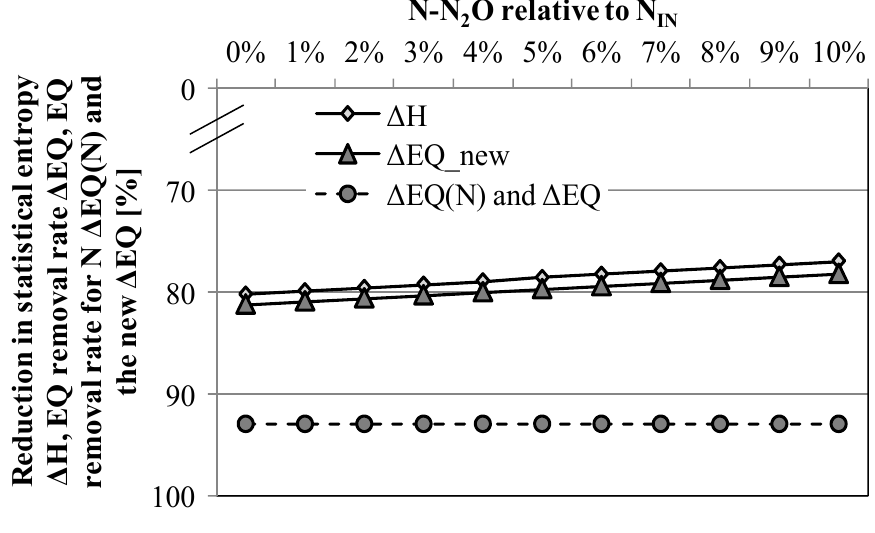
O-emissions on the N-removal performance measured by Δ EQ Figure 3. Effect of N 2 Δ H and on the entire cleaning performance according to both Δ EQ and EQ